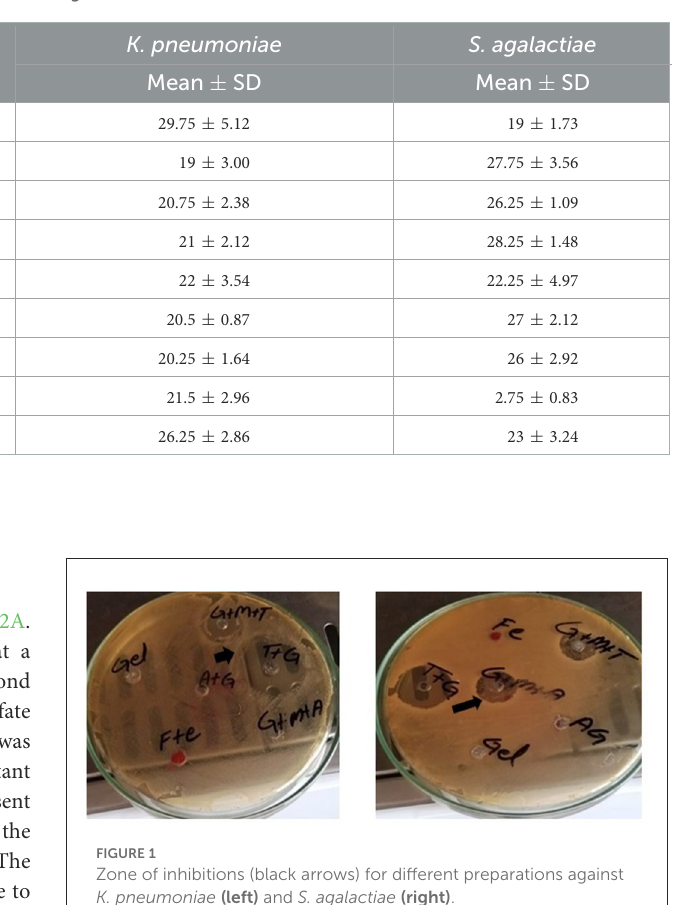
TABLE 1 Zone of inhibitions (mm) shown by K. pneumoniae and S. agalactiae against antibiotics.